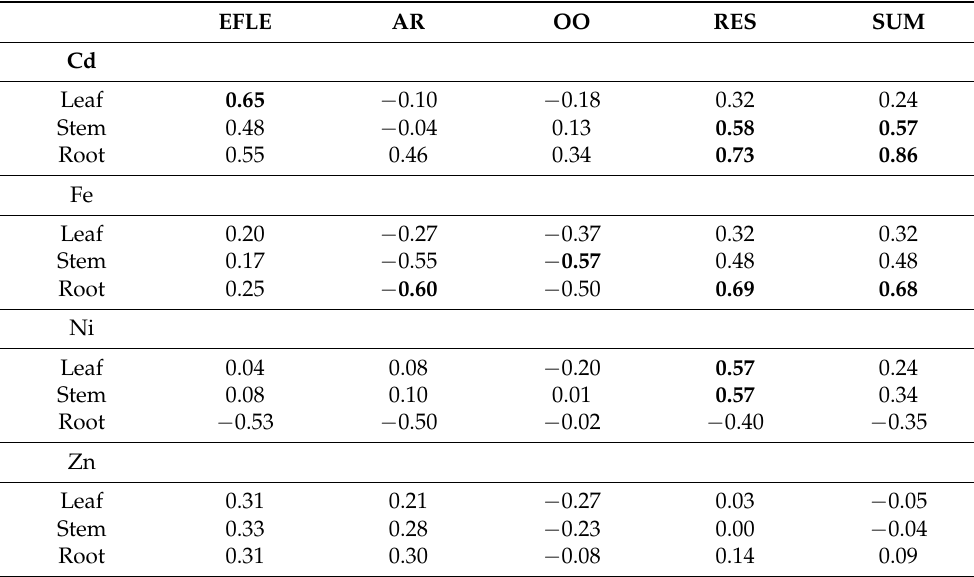
Table 3. Correlation coefficients of concentrations log 10 (mean + 1) of Cd, Fe, Ni, and Zn between Ama- ranthus viridis (leaves, stems, and roots), and their habitat topsoils (geochemical fractions) (N = 11). EFLE AR OO RES SUM Cd Leaf 0.65